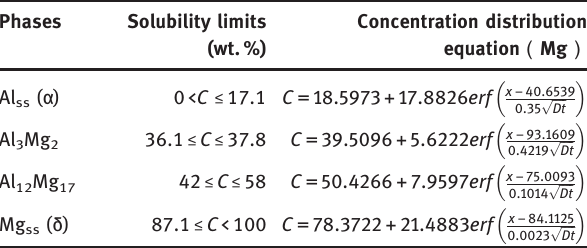
Table 1: Concentration distribution equations calculated by Matlab. Phases Solubility limits Concentration distribution (wt.%)